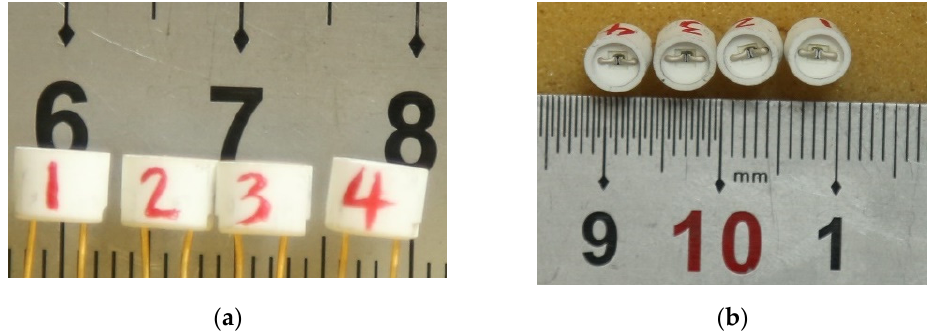
Figure 16. Structure of low-energy SCB. ( a ) Top view of the SCB; ( b ) side view of the